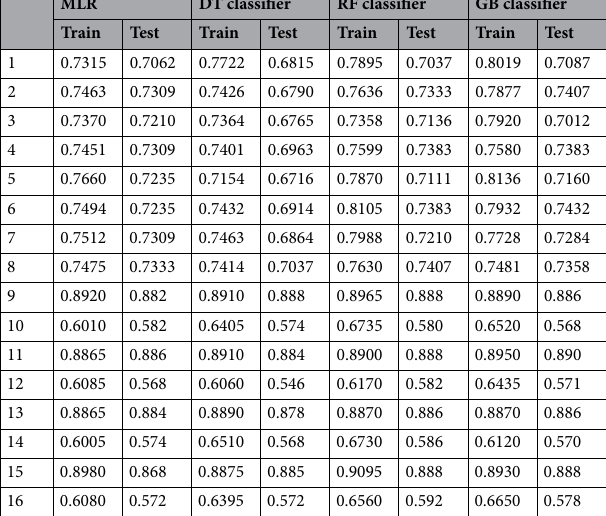
Table 8. Machine learning accuracy.